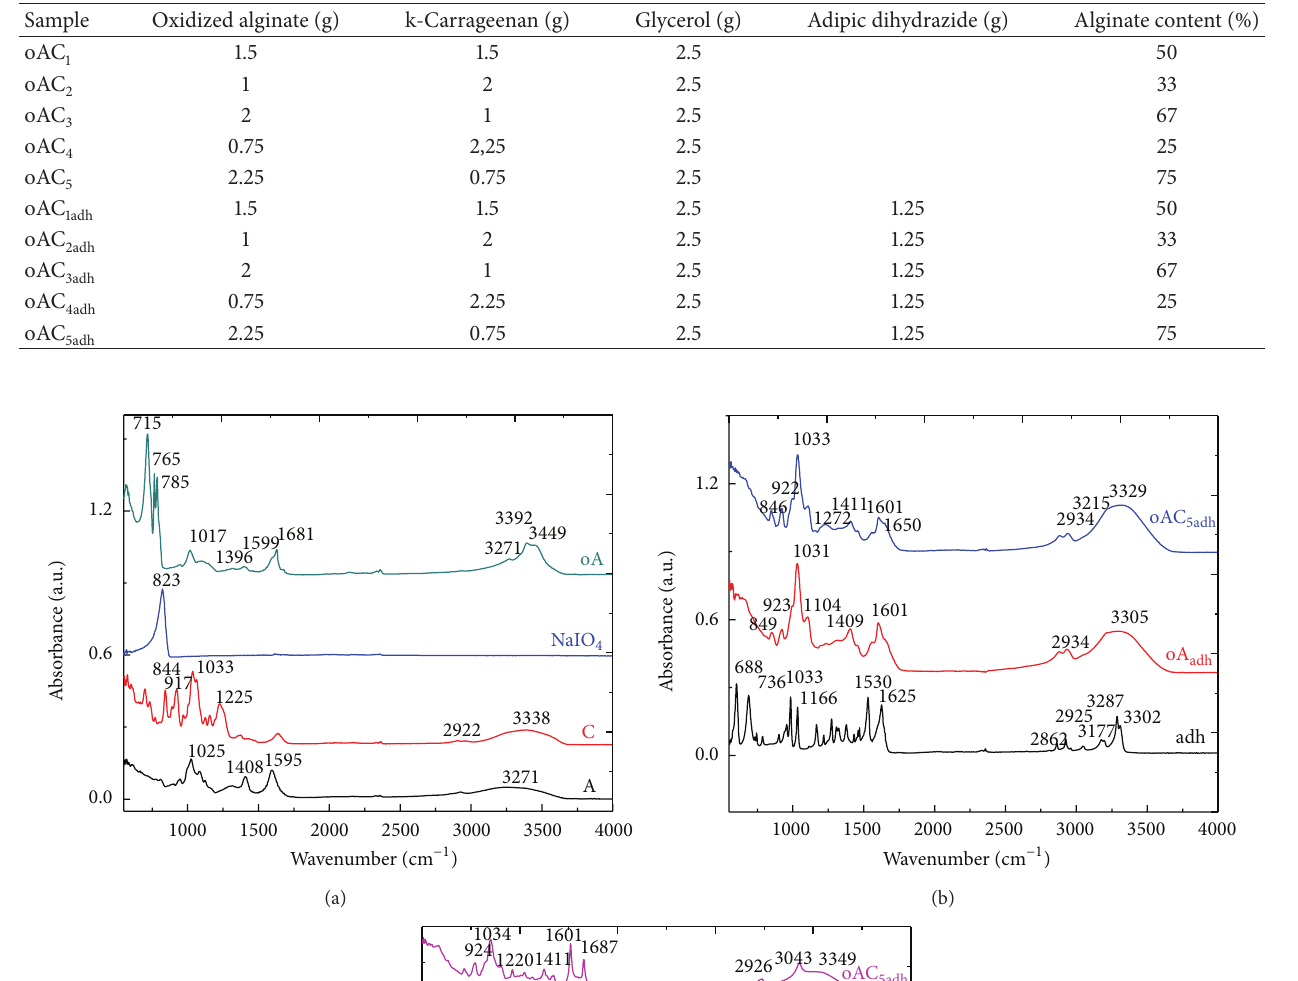
Table 1: Samples composition: the uncross-linked films (oAC oAC